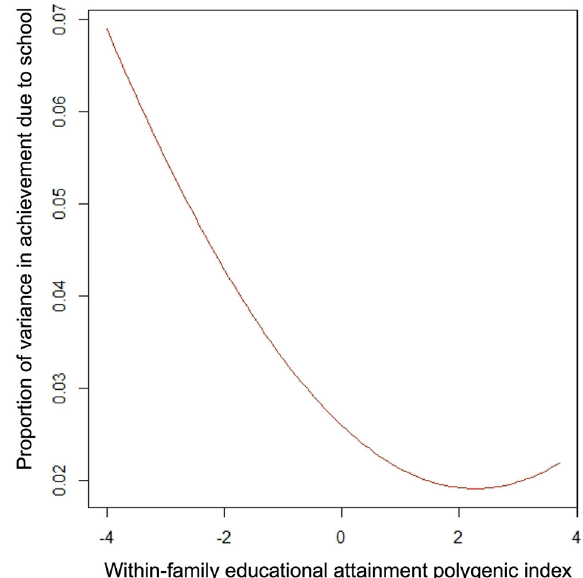
Fig. 3 School effects on achievement vary across values of the within-family EA-PGI. For students with within-family EA-PGI that are 2 SD below the mean, schools explain ~4% of the phenotypic variance, whereas for students with PGI 2 SD above the mean, schools explain ~2%.